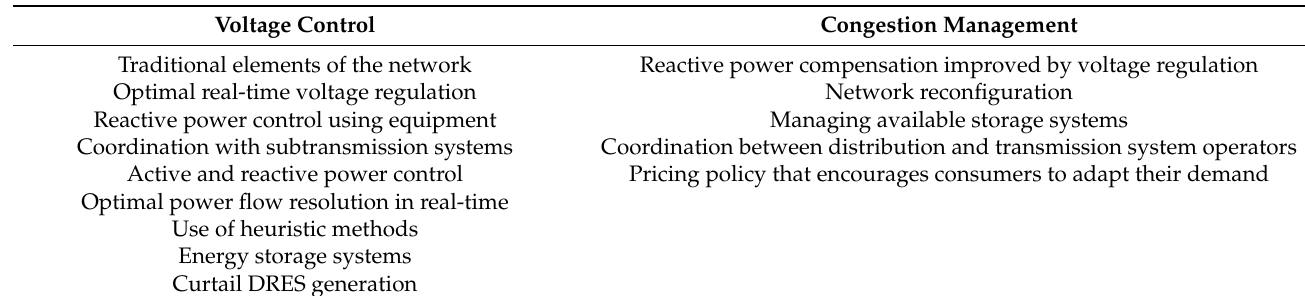
Table 1. Methodologies applied for voltage control and congestion